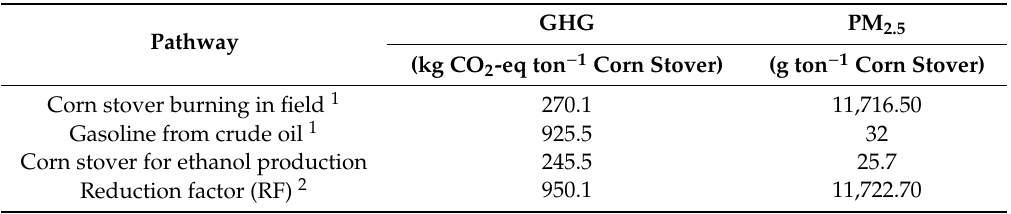
Table 5. Greenhouse gas (GHG) and fine particulate matter (PM 2.5 ) emissions from the reference case and the corn stover based ethanol production.